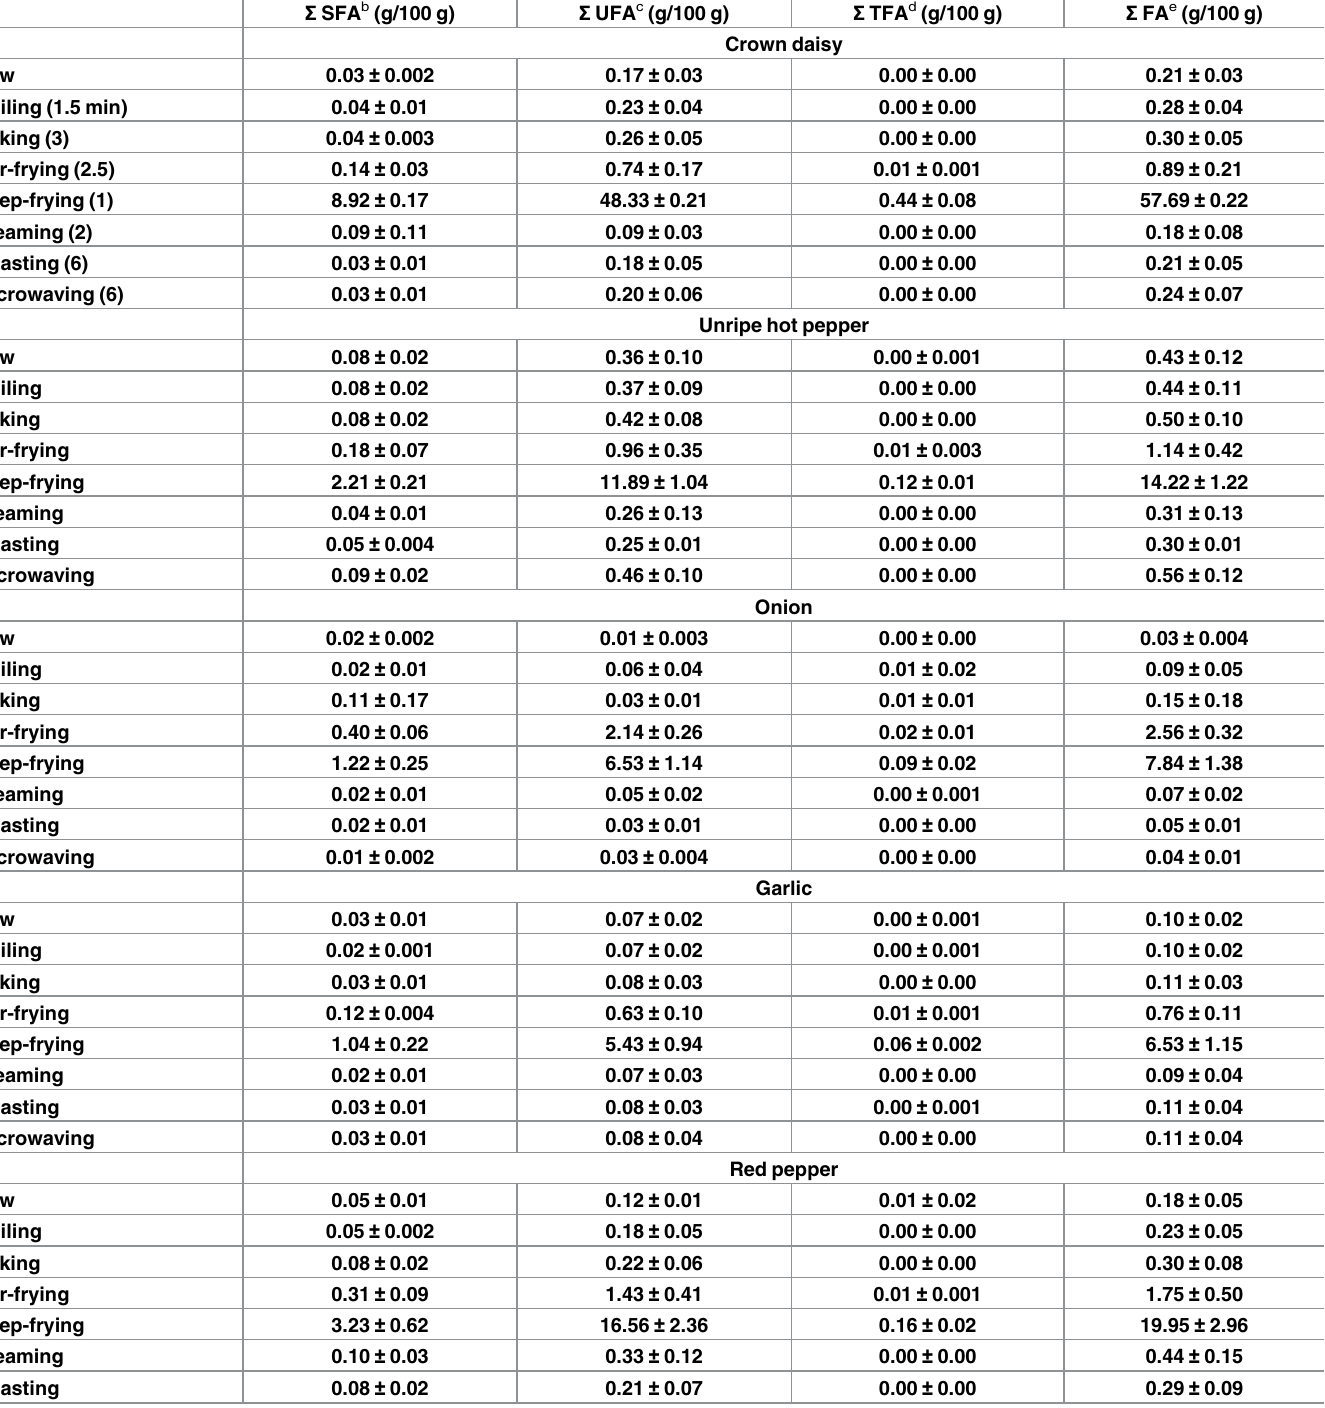
Table 2. Total fatty acid profiles of 5 spices and their cooked products a